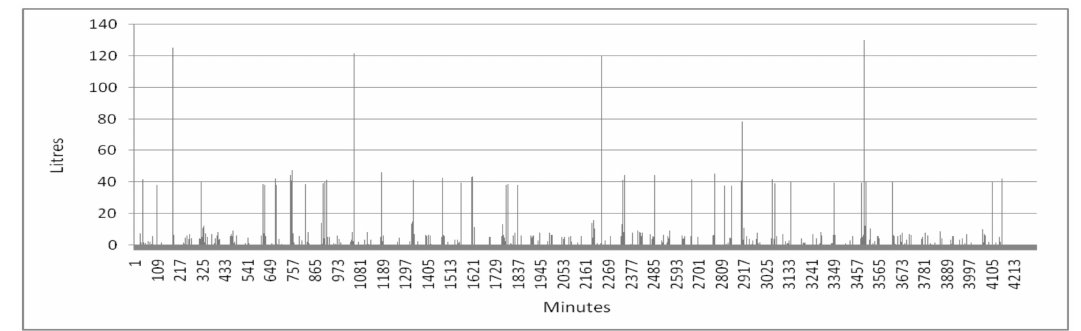
Figure 6. Example of domestic hot water (DHW) profile for a three-member family, this represents all hot water (HW) draw-off during a generic